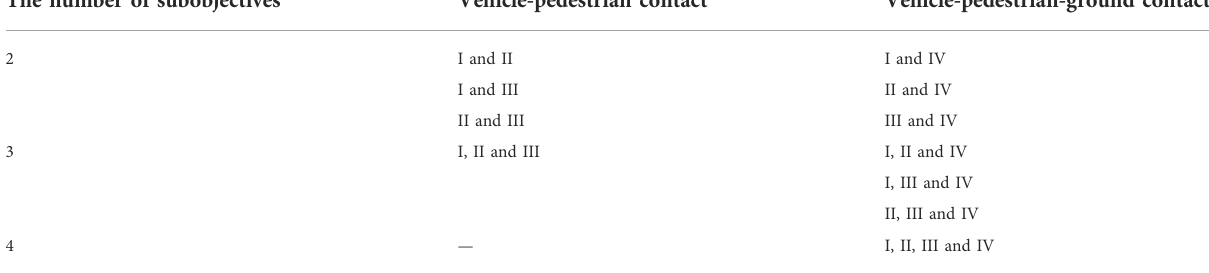
TABLE 3 Optimization groups based on the number of collision marker pairs and the type of collision contact. There are 11 groups based on the number of subobjectives and the contact during the collision. The number of